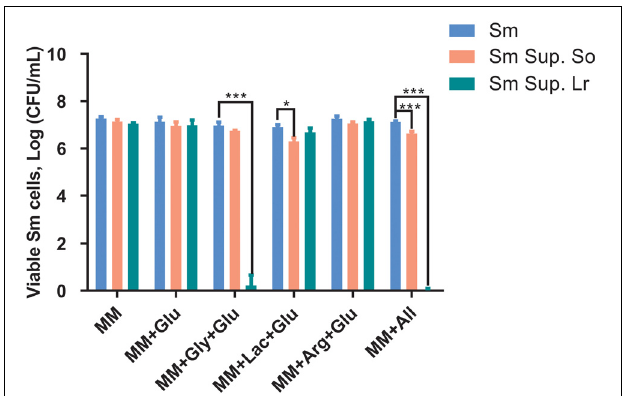
FIGURE 3 | Changes in colony-forming units (Log CFU/mL, means ± standard deviations) of S. mutans after being cultured in the supernatant (Sup.) of S. oligofermentans (So) and L. reuteri (Lr). S. mutans was cultivated in minimal medium (MM), MM with glucose (MM+Glu), MM with glycerol and glucose (MM+Gly+Glu), MM with Lactic acid and glucose (MM+Lac+Glu), MM with arginine and glucose (MM+Arg+Glu) and all-full medium (MM+all) (controls), as well as supernatants of the probiotics. Glucose was additionally added to the MM+Gly, MM+Lac, and MM+Arg group of probiotic supernatants as it is described in section “Culture of S. mutans With Probiotic Supernatants.” Each experiment was repeated three times. Dunnett’s test: * P < 0.05, *** P < 0.001, versus